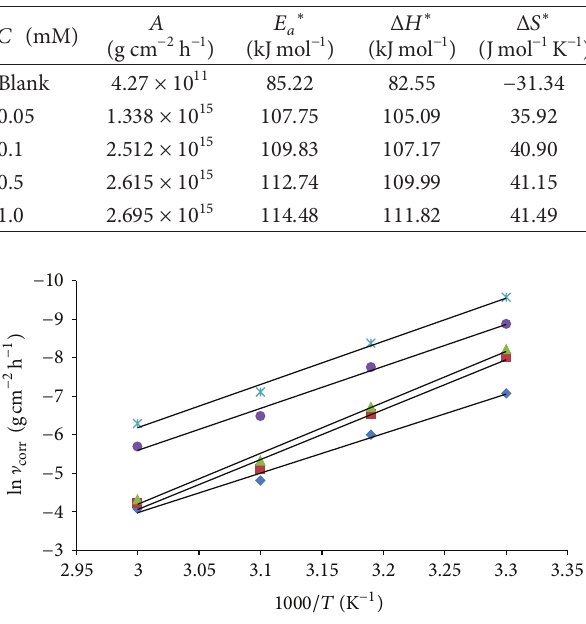
Table 3: Activation parameters of dissolution reaction of mild steel in 1M HCl with RS at different concentrations.